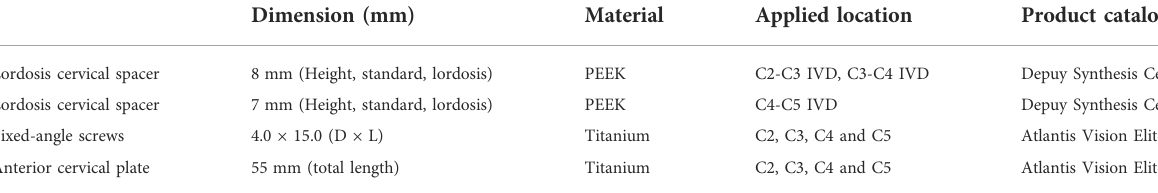
TABLE 1 Implant con fi guration in the ACDF surgery. Intervertebral disc